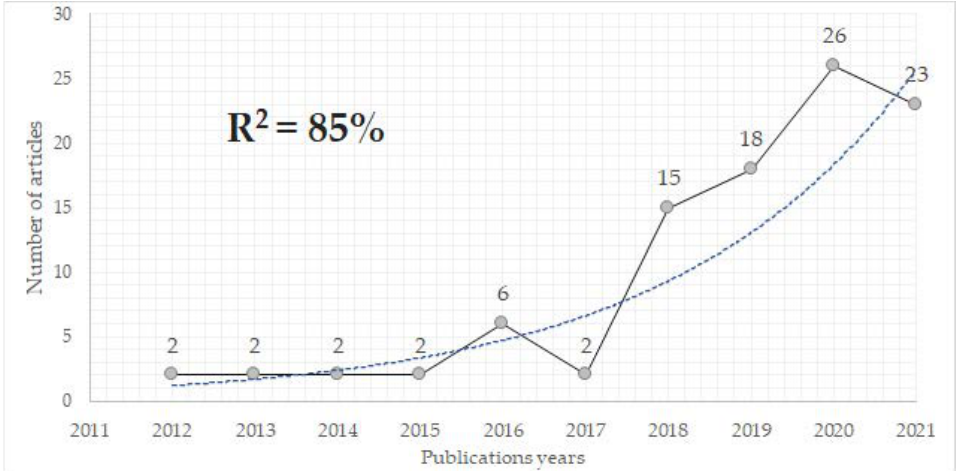
Figure 1. Temporary publication trend on WB-EMS between 2011 and 2021. Gris line: number of articles published per year. Blue line: exponential growth trend.